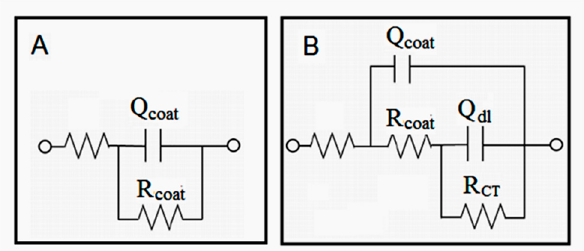
Figure 12. Equivalent circuit models for the ( A ) TO/TMMP-TMTGE and ( B ) TMMP-TMTGE self-healing materials.